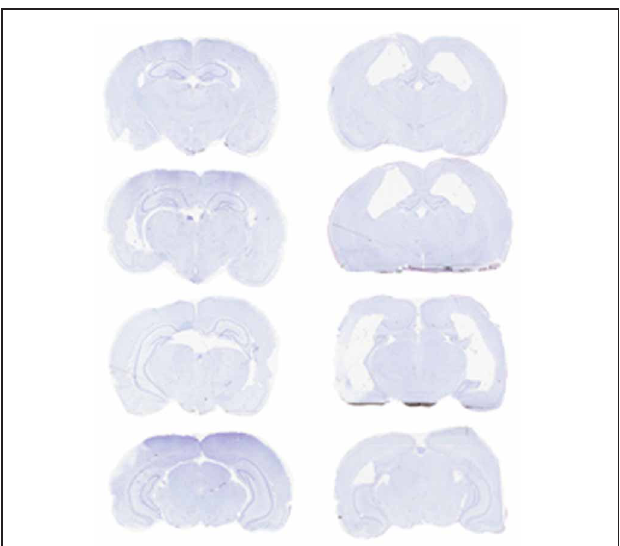
FIGURE 3 | Photomicrographof representative sections from a sham-lesioned (left column) and hippocampus-lesioned (right column) animal. The latter sections are from F3401 ( Table 2 ), and the lesion extent in this subject was close to the average of the group.